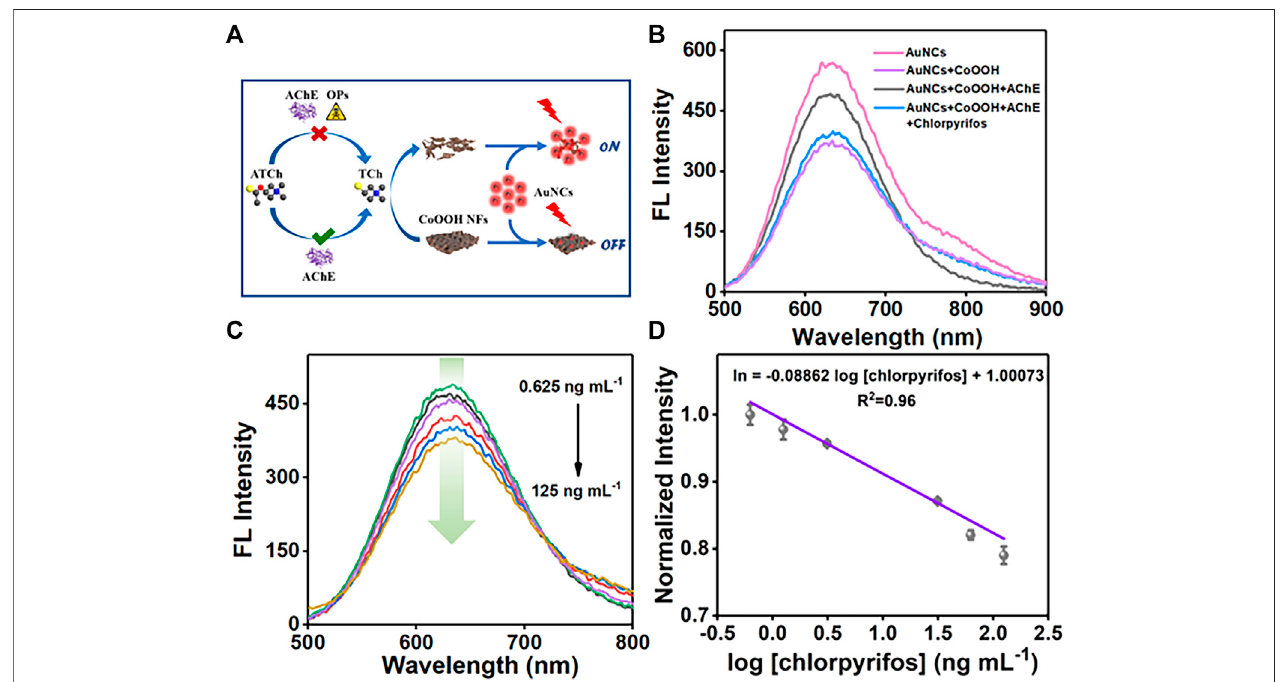
FIGURE 2 | (A) Analysis strategy of chlorpyrifos. (B) Fluorescence spectra of AuNCs, AuNCs/CoOOH, and AuNCs/CoOOH/AChE/ and AuNCs/CoOOH/AChE + chlorpyrifos. (C) Fluorescence intensity of the system toward different concentrations of chlorpyrifos. (D) Linear relationship between fl uorescence intensity and the logarithm of the concentration of chlorpyrifos.